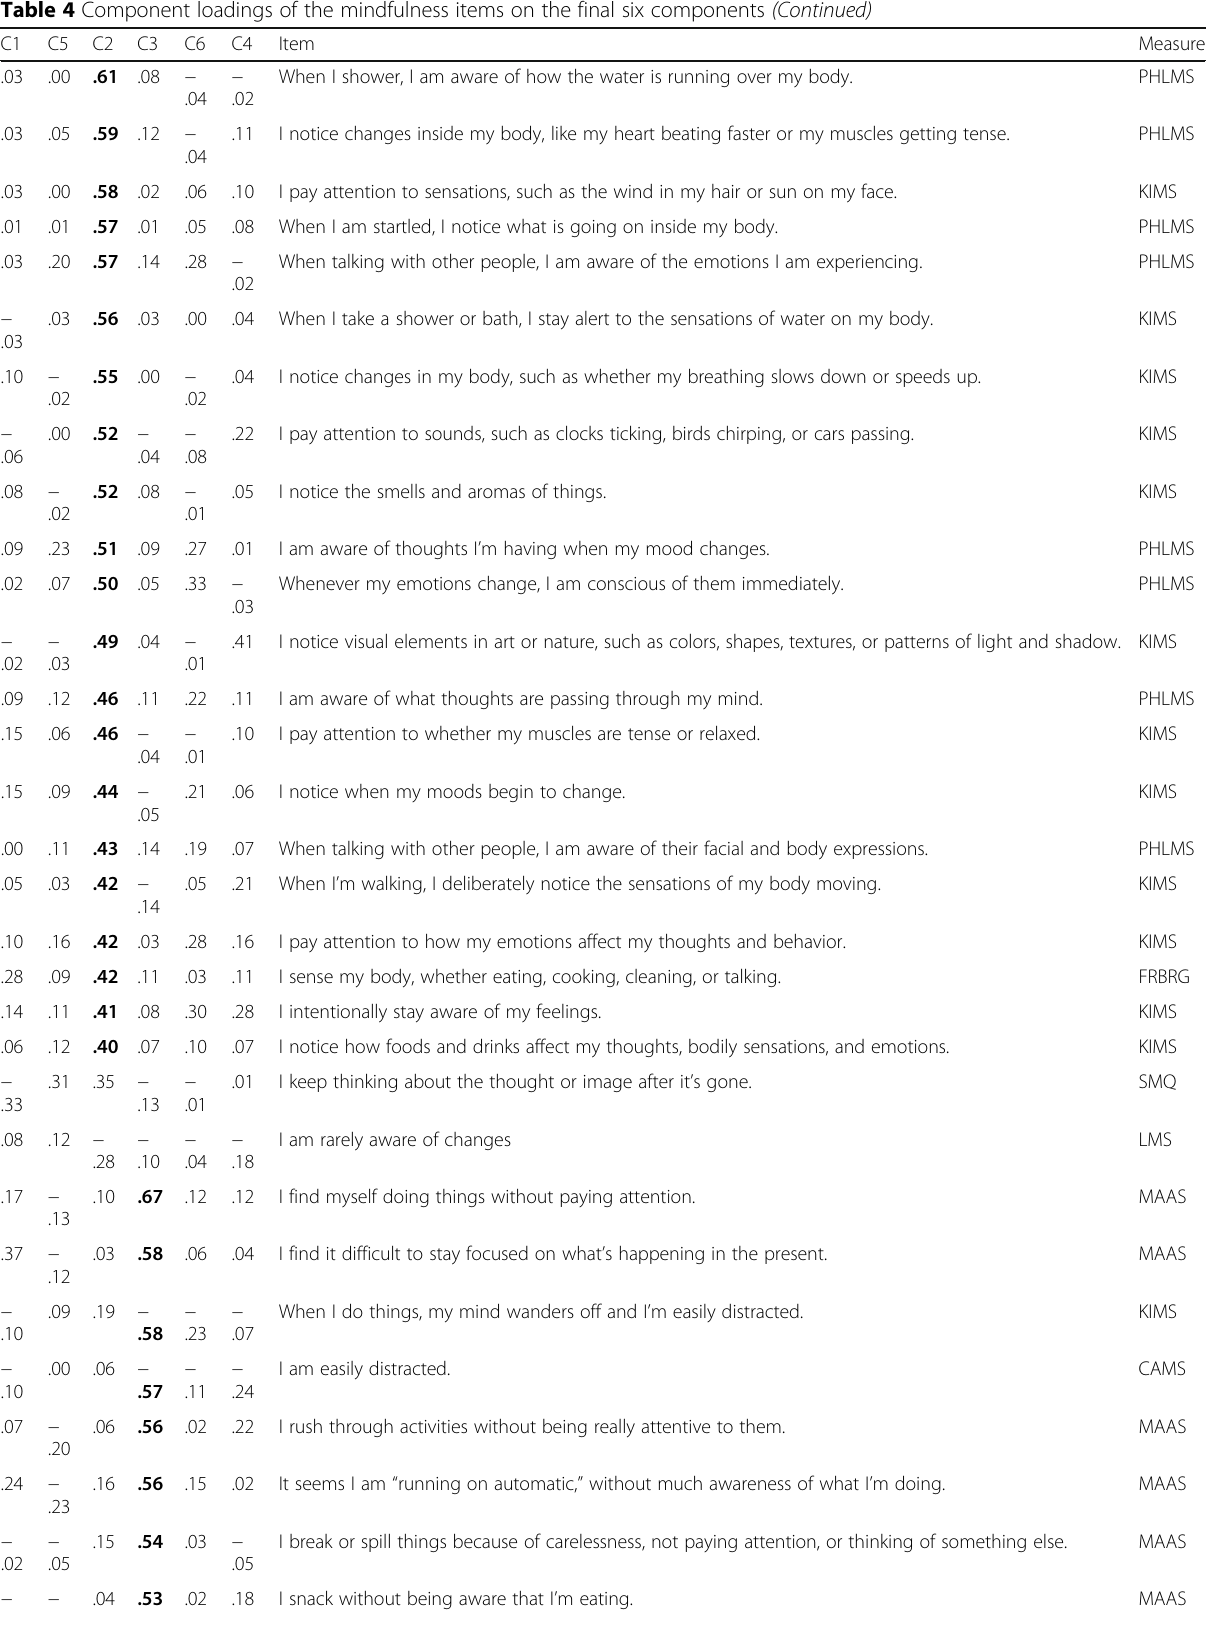
Table 4 Component loadings of the mindfulness items on the final six components (Continued)